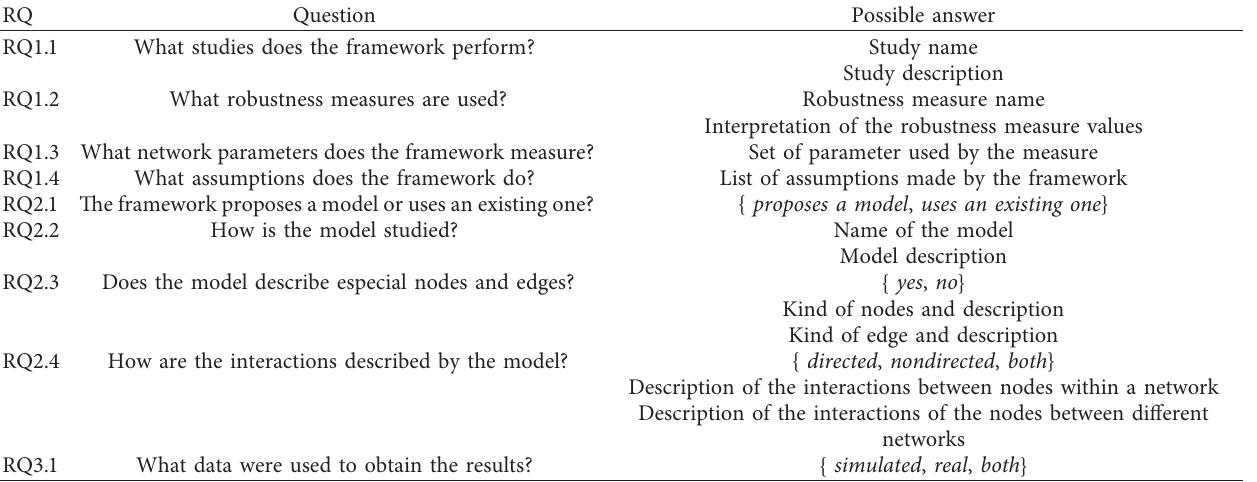
Table 2: Research question breakdown (the research questions (RQ) are presented in Section